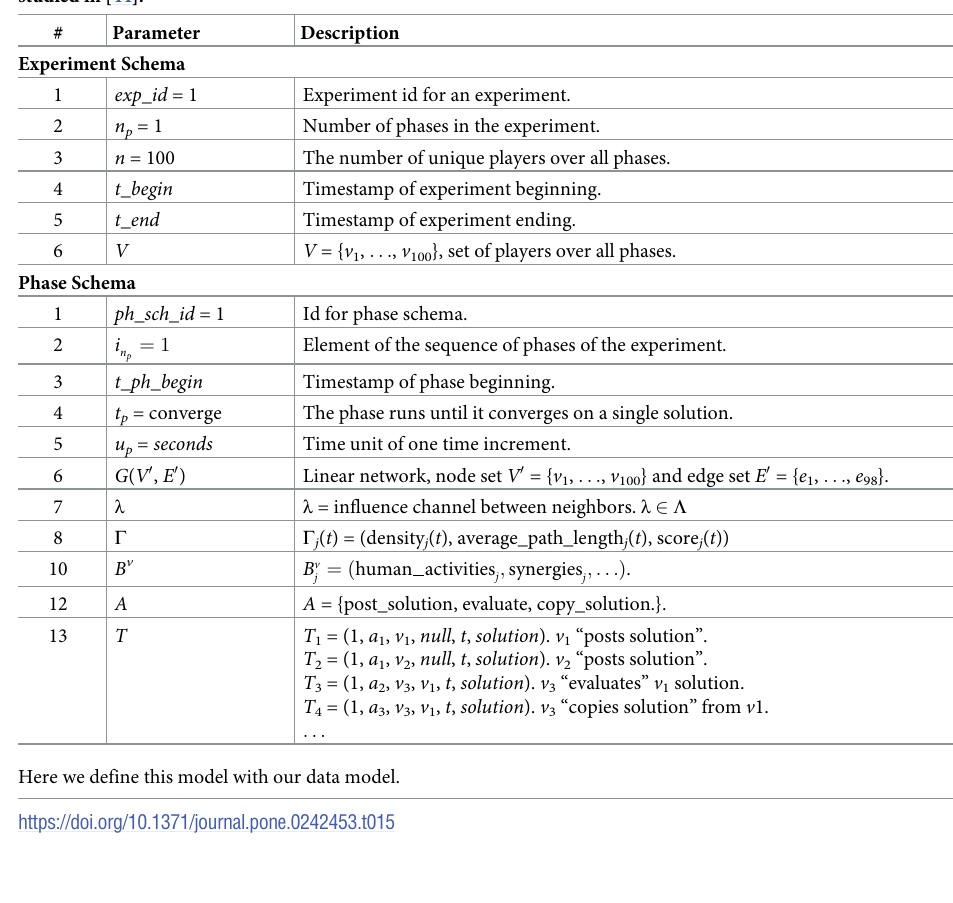
Table 15. How the structure of communication networks among actors can affect system-level performance is studied in [44].